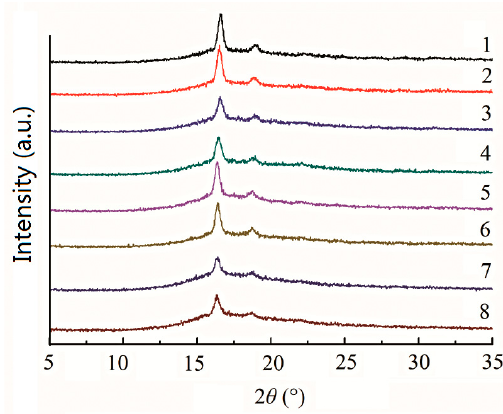
Figure 7. Wide angle X-ray diffraction patterns of isothermally crystallized samples. ( 1 ) PLA;